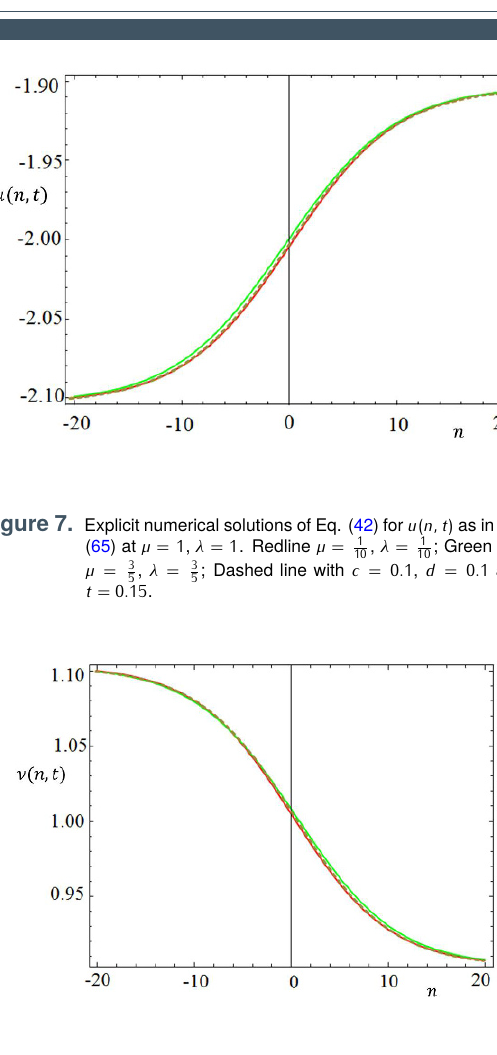
Figure 8. Explicit numerical solutions of Eq. (43) for ν (66) at µ = 1 , λ = 1 . Redline µ = 1 , λ = 3 ; Dashed line with c = 0 . 1 , d = 0 . 1 and µ = 3 5 5 t = 0 . 15 .